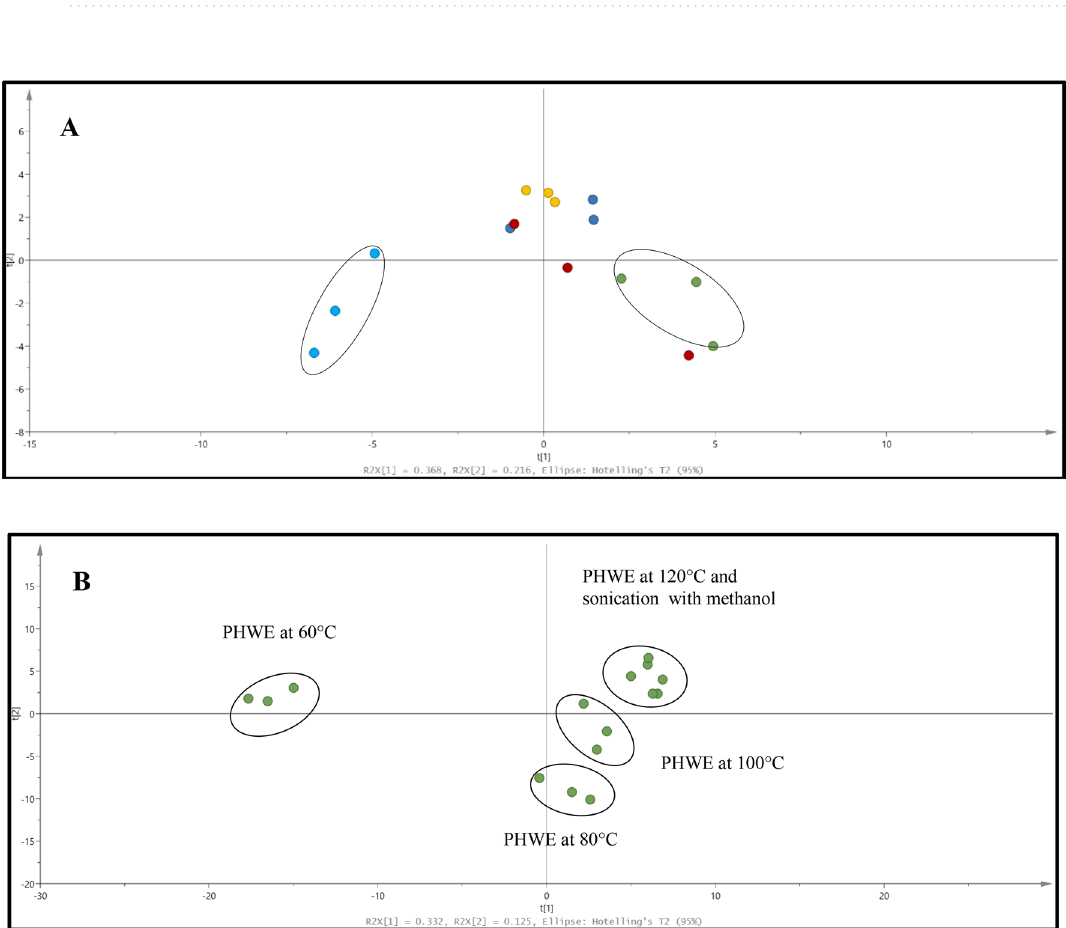
Figure 2. PCA score plot of ( A ) LC/UV profile and ( B ) LC/MS profile of avocado seed extracts. ( A ) PCA score plot of LC/UV profile detected at 254 nm, Green: PHWE at 60 °C, Dark blue: PHWE at 80 °C, Red: PHWE at 100 °C, Yellow: PHWE at 120 °C & Light blue: sonication with methanol. ( B ) PCA score plot of LC/MS profile of avocado seed extracts by PHWE at 60 °C, 80 °C, 100 °C, 120 °C and sonication with